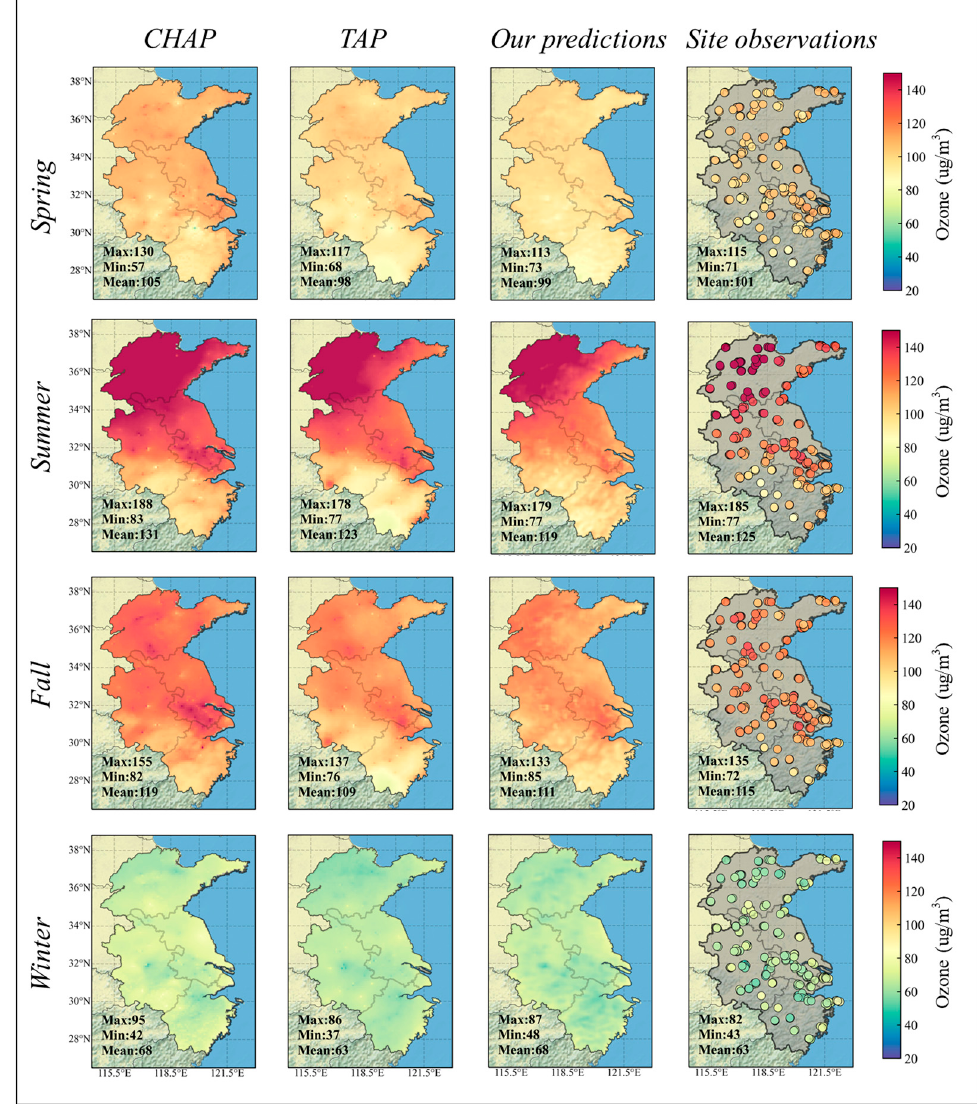
Figure 8. Quarterly averages of MDA8 ozone of CHAP, TAP, our predictions, and site observations.